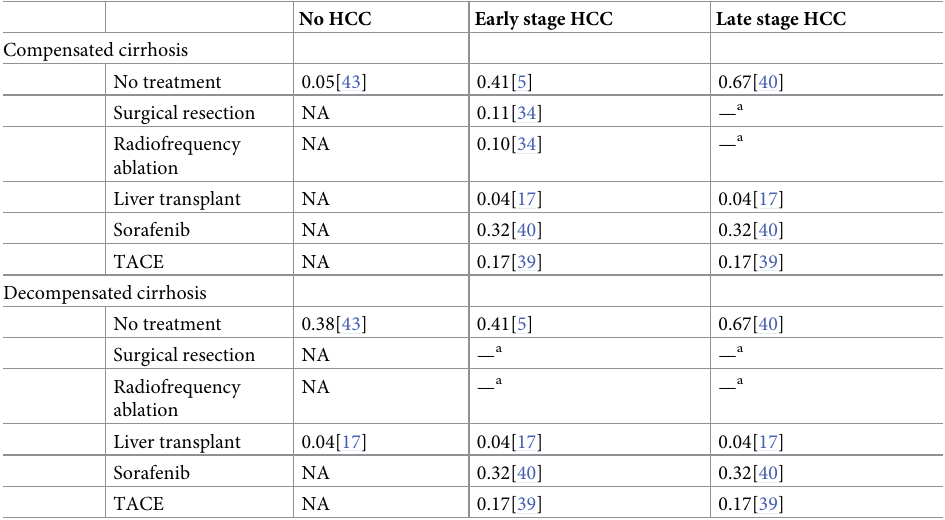
Table 1. Annual probability of excess mortality by disease and